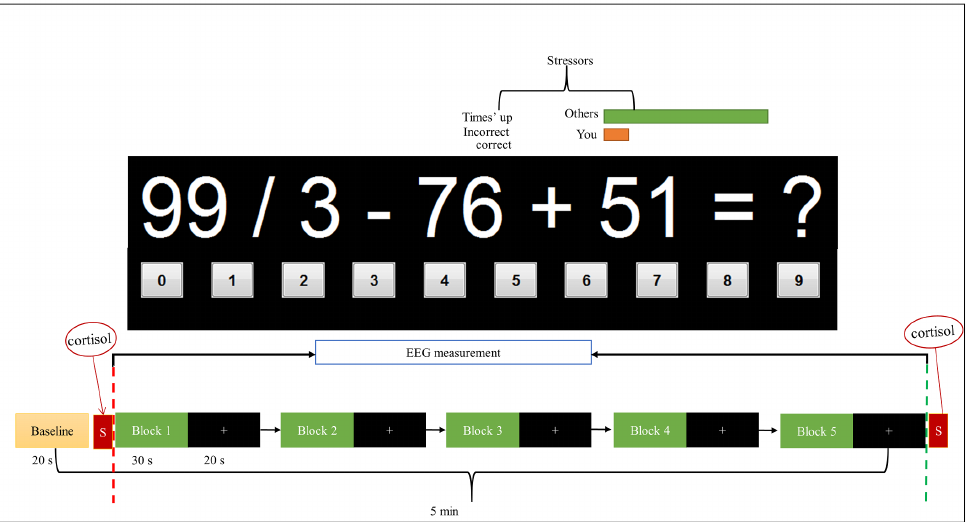
Figure 1. Experiment block design. A total of five active blocks for each task with salivary alpha amylase (SAA) cortisol was collected before and after the stress task and presented by the letter S with a red background. For each block, arithmetic tasks are given for the 30 s followed by 20 s of rest. The red dashed line marks the start of the task, and the green dashed line marks the end of the task (the marking is done at every